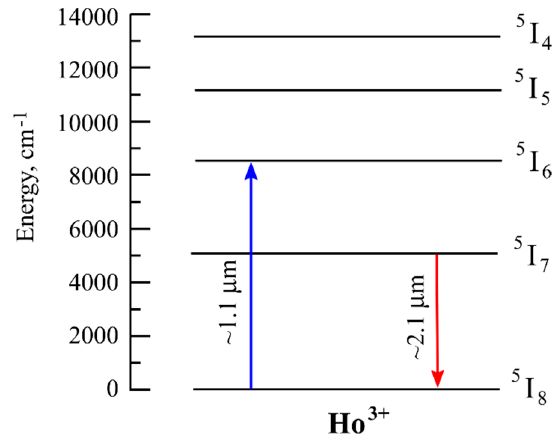
Figure 7. Simplified energy level diagram for Ho-doped tellurite glass.